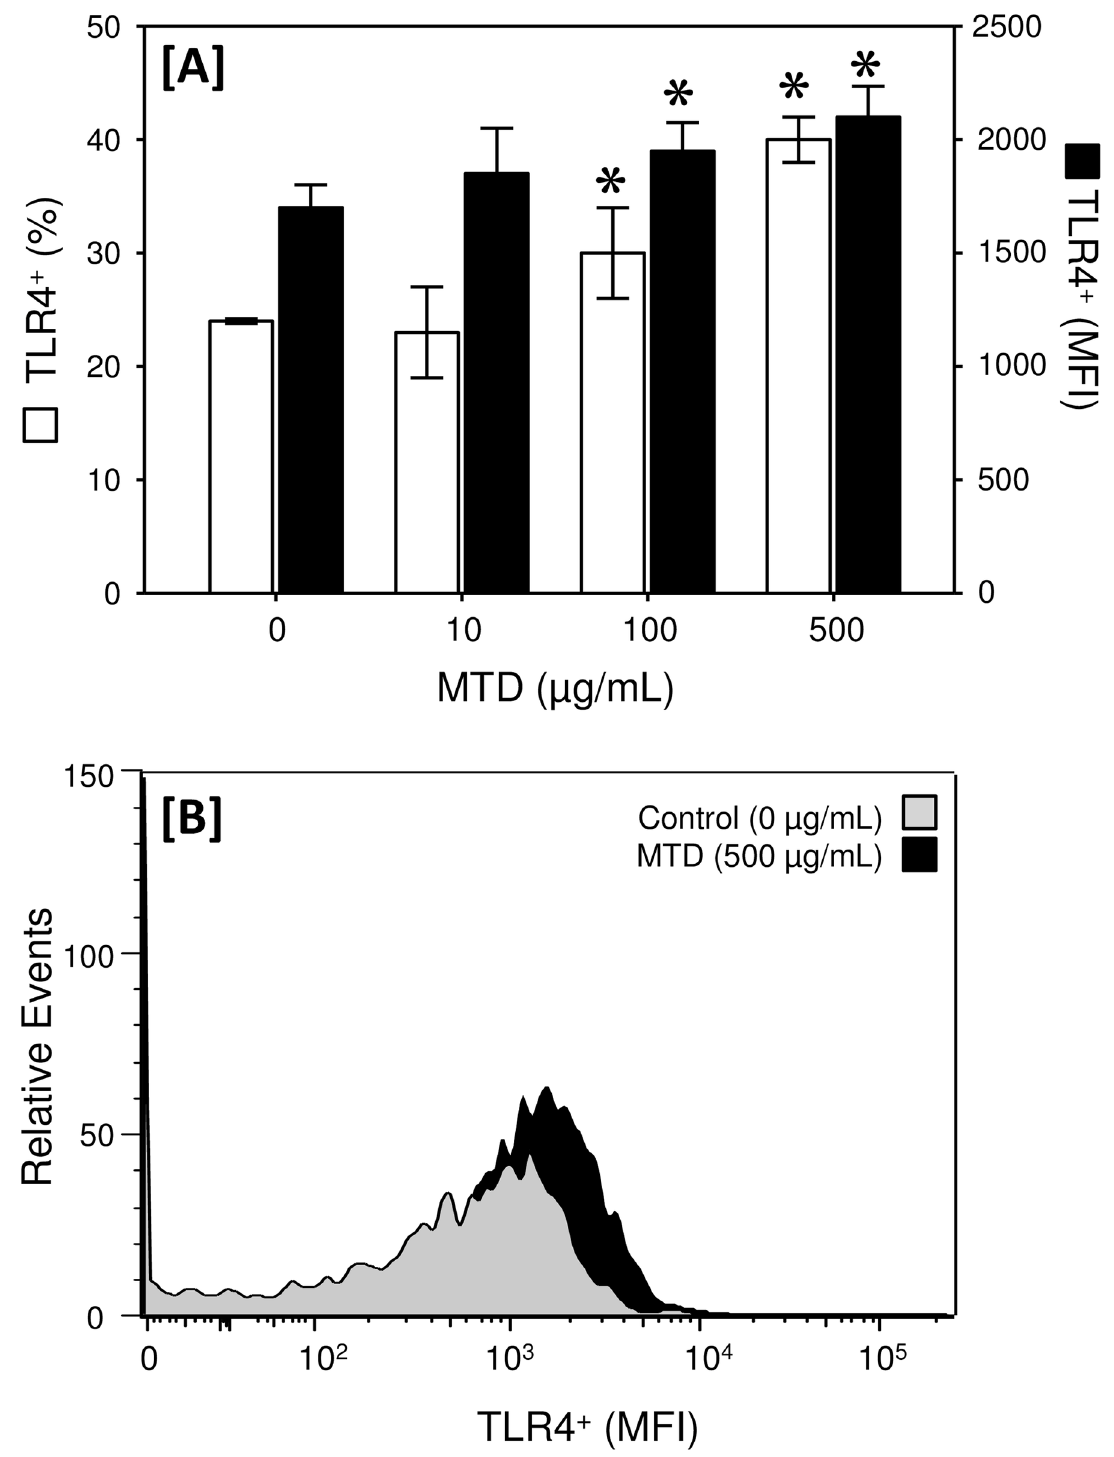
Fig 3. MTDs increase TLR4 expression by dermal γδ T-cells. Skin T-cells were incubated with MTDs (0 – 500 μ g/mL) and TLR4 expression on the γδ T-cell population was determined by flow cytometry as described in the materials and methods. Panel A shows the percentage of the cells positive for TLR4 expression (TLR4 + ) □ and the mean fluorescence intensity (MFI) of the TLR4 + cells) ■ . The data are Mean ± SEM for cells from 5 mice. Panel B shows a representative histogram plot for TLR4 expression by control cells and following stimulation with 500 μ g/mL MTDs. * p < 0.05 as compared with control (0 μ g/mL).